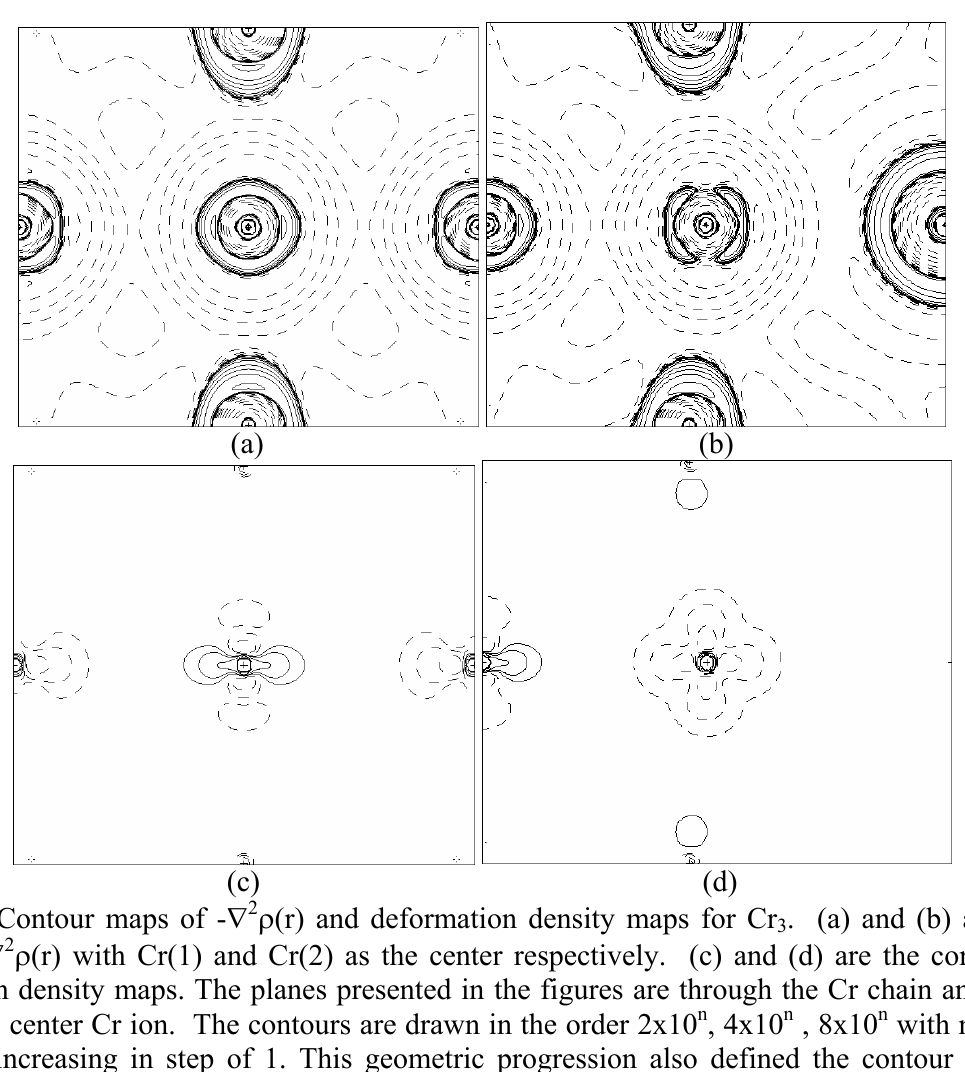
. (a) and (b) are contour 3